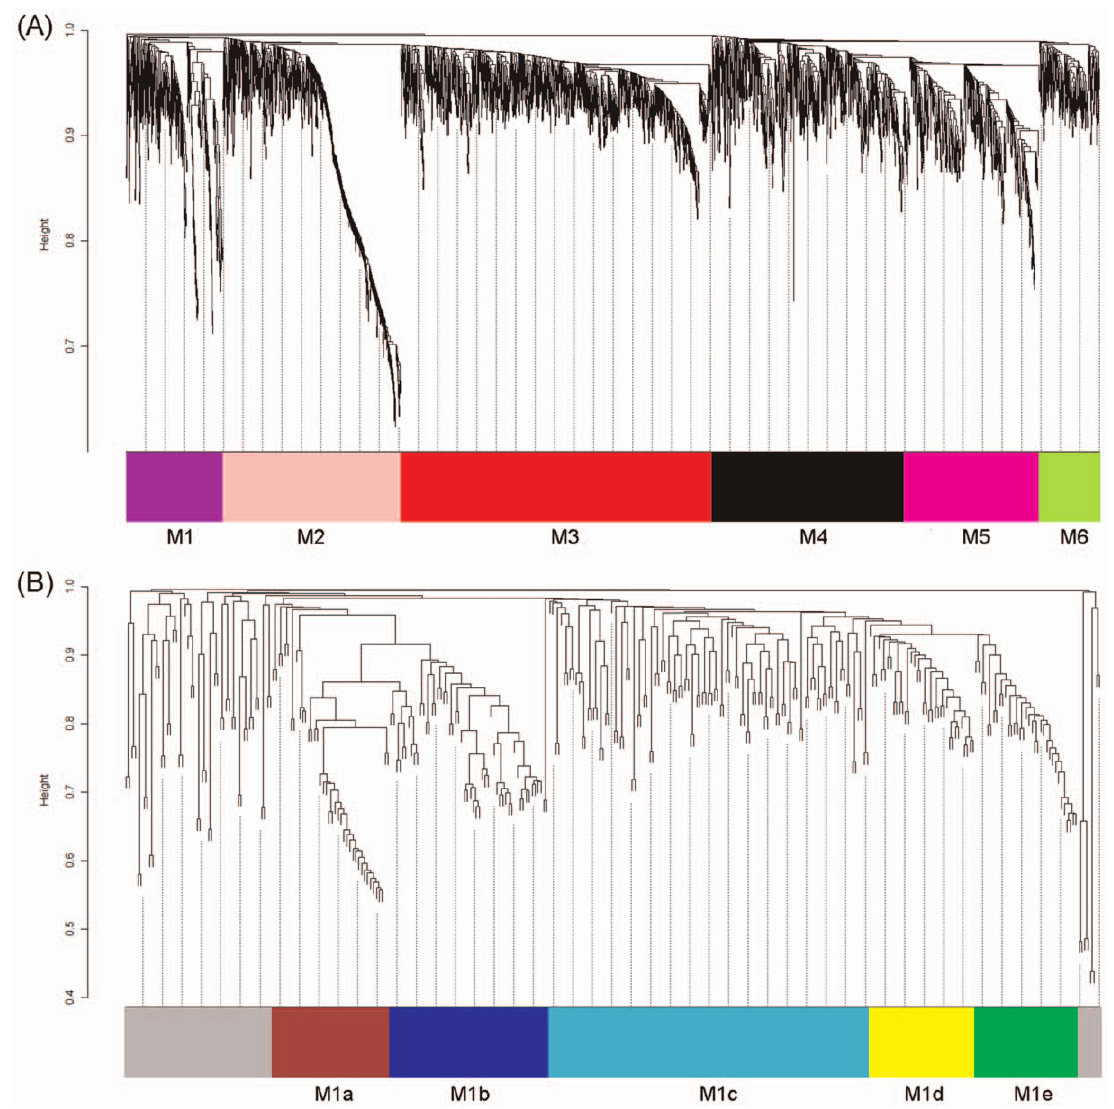
Figure 1. Network analysis of the oyster gill transcriptome during recovery after heat shock (RHS). (A) and subnetwork analysis of the RHS-responsive module M1 (B). Dendrograms are produced by average linkage hierarchical clustering of genes on the basis of topological overlap (see Methods for details). Modules of coexpressed genes are labelled in unique colors. Unassigned genes are labelled in grey.